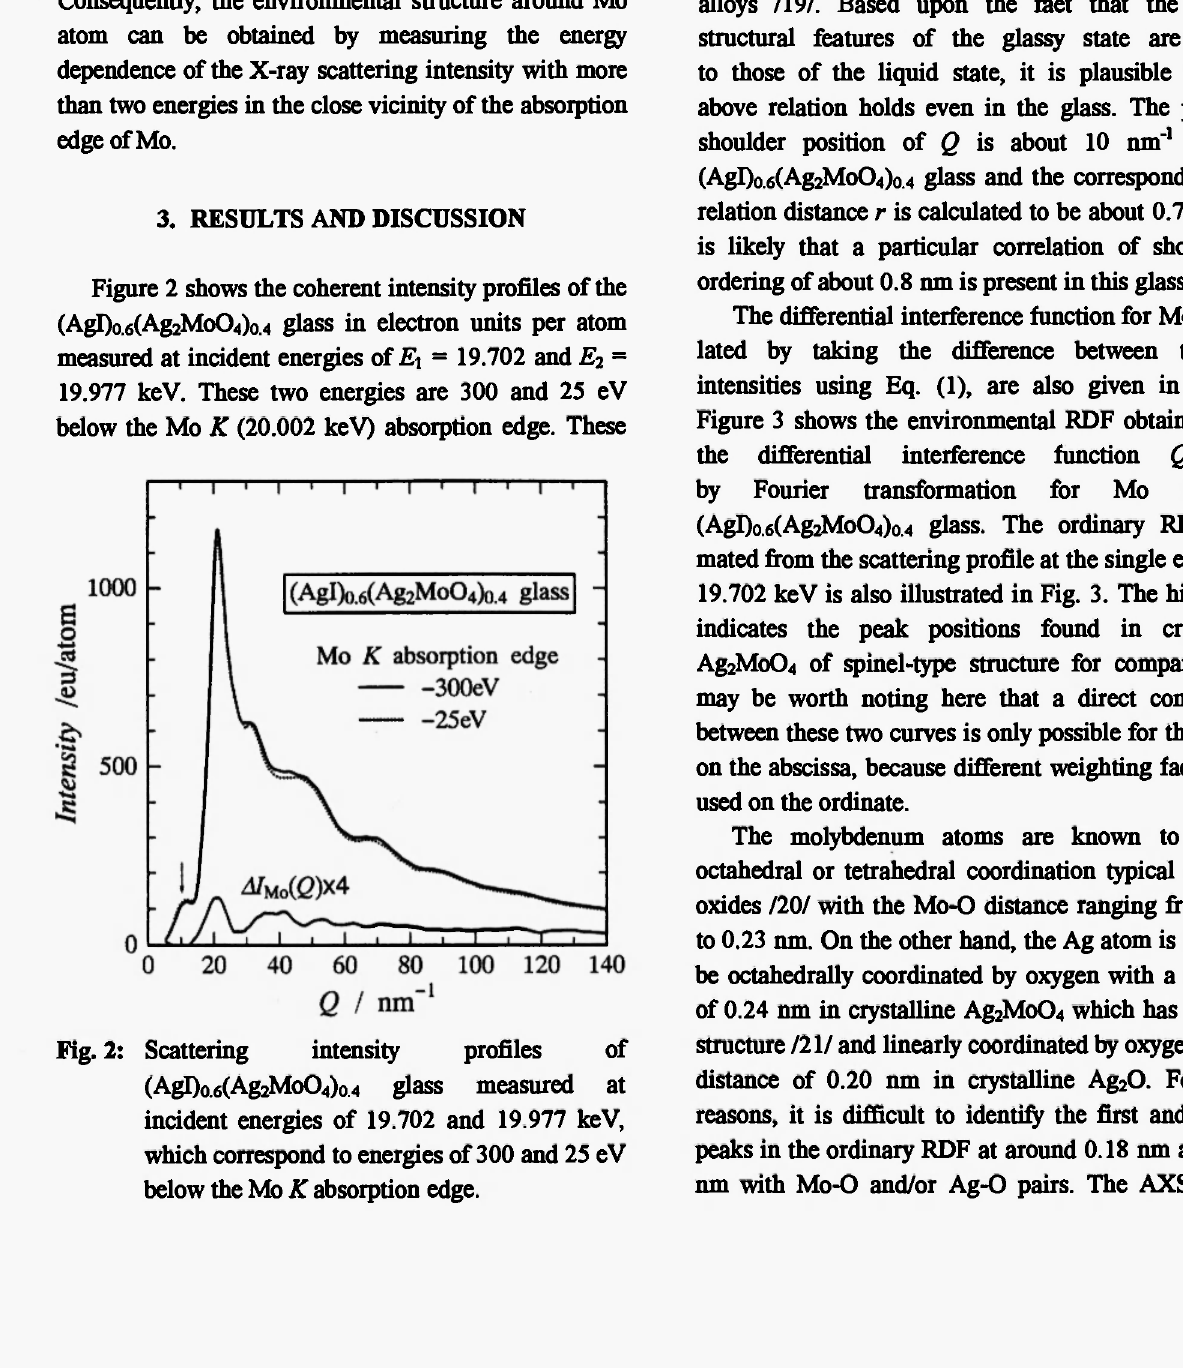
Fig. 2: Scattering intensity profiles of (AgI) .6(Ag2Mo0 )o.4 glass measured at 0 4 incident energies of 19.702 and 19.977 keV, which correspond to energies of 300 and 25 eV below the Mo Κ absorption